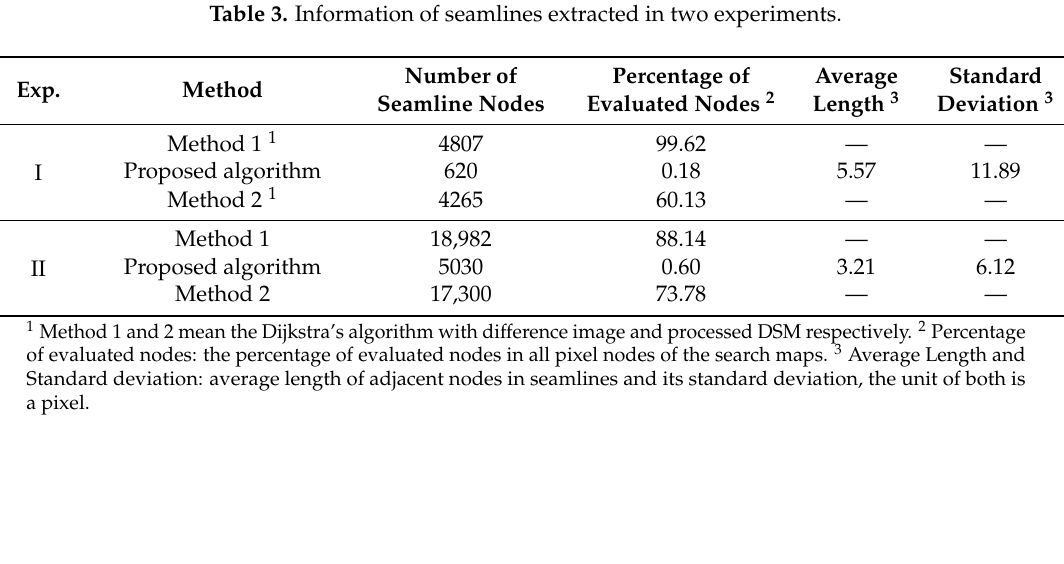
Table 3. Information of seamlines extracted in two